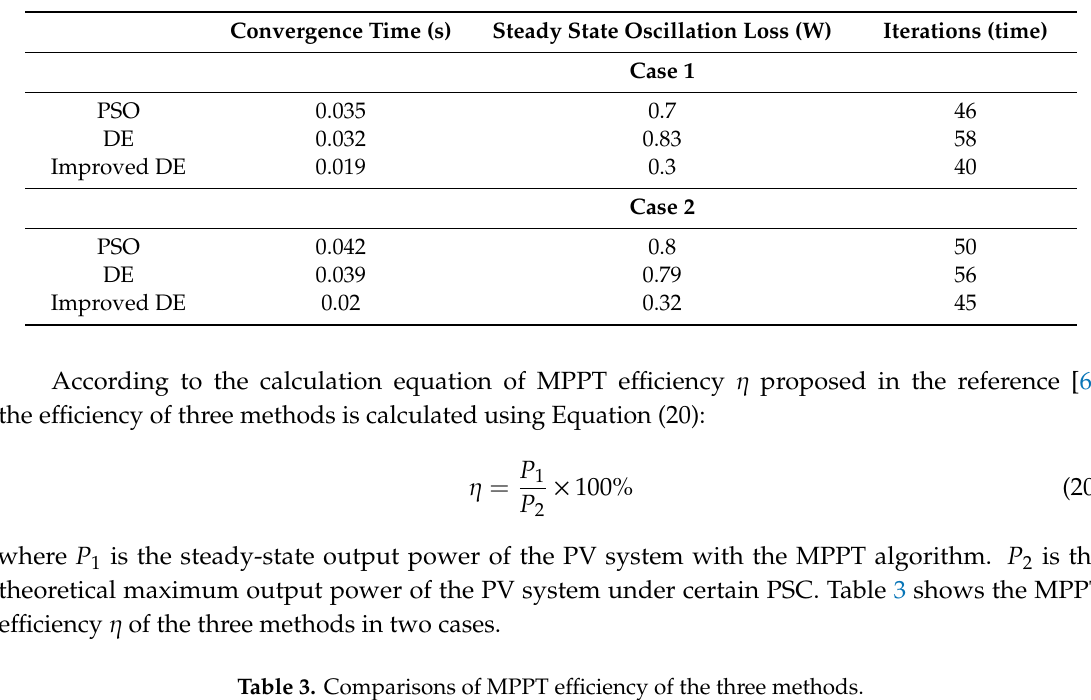
Table 2. Comparisons of convergence speed, accuracy and iteration times of the three methods.